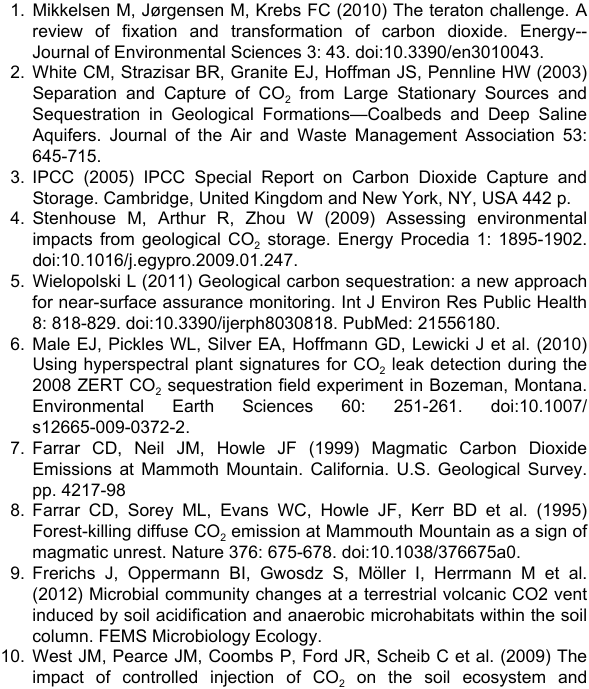
Table S3. Factor analysis.